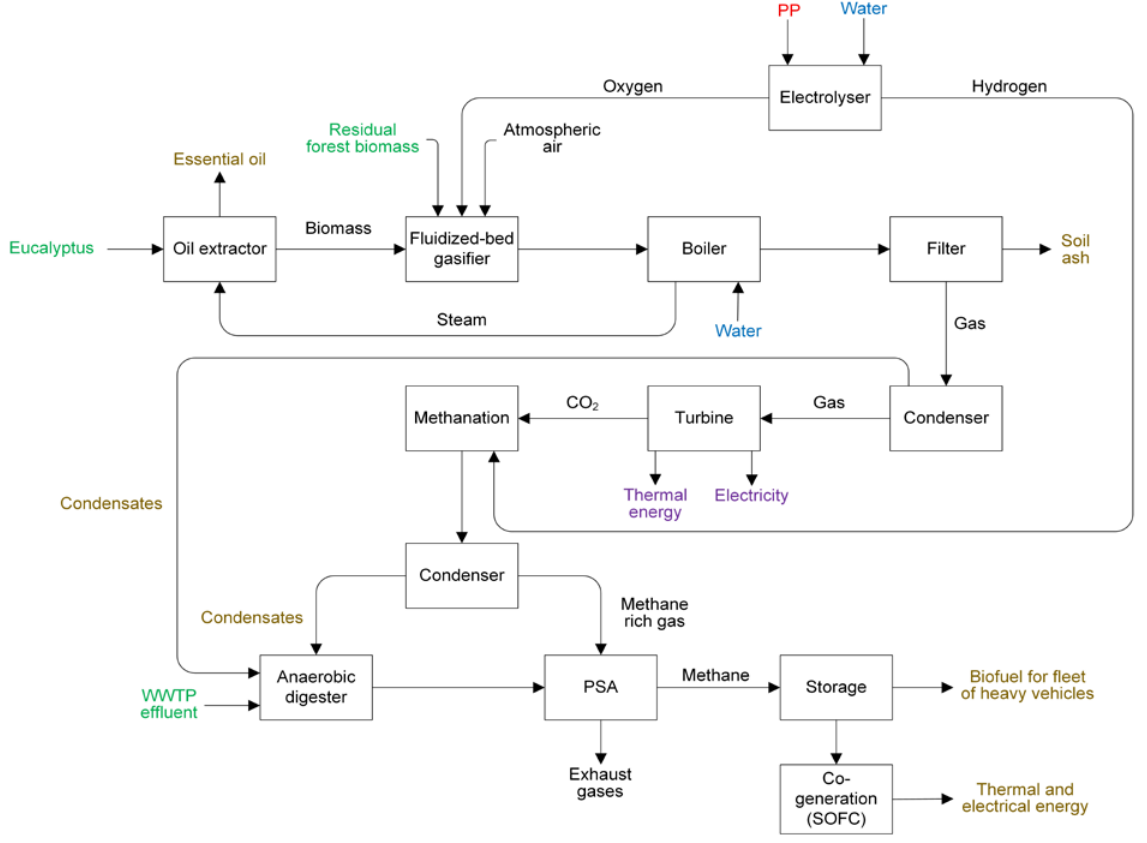
Figure 1. Representative flowchart of the proposed biorefinery concept: complex multi-product